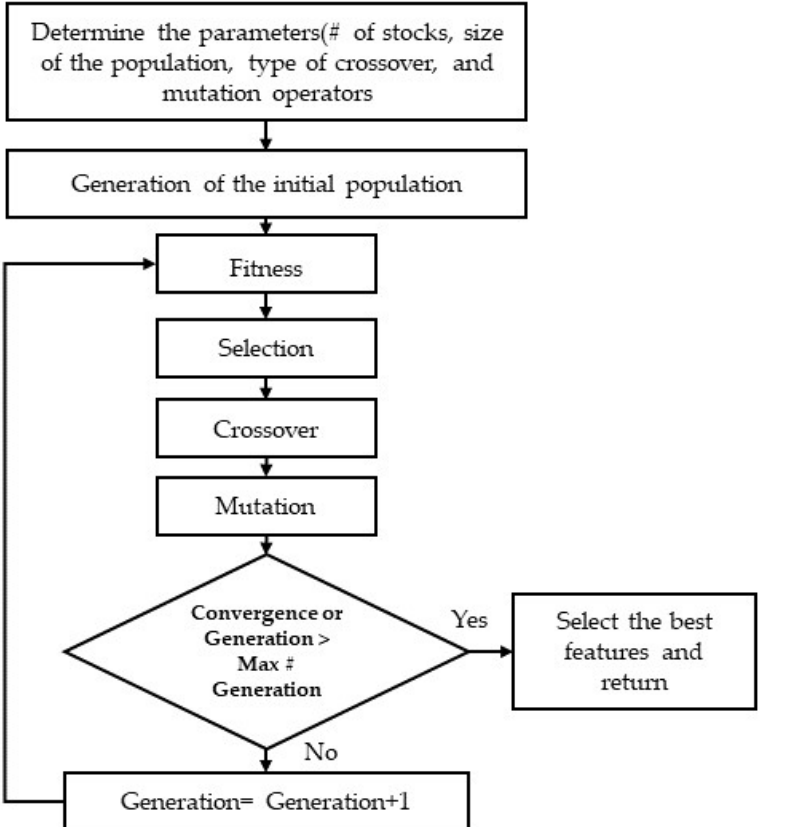
Figure A2. A flow chart of genetic algorithm optimization.